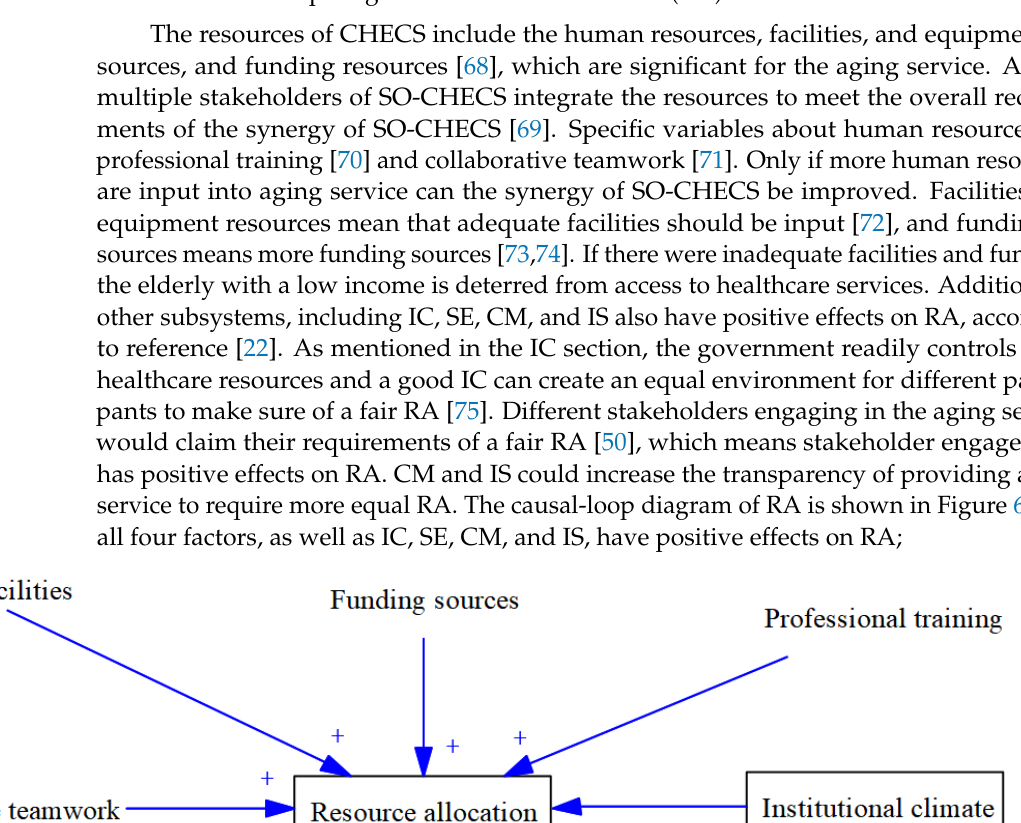
Figure 6. The causal-loop diagram of RA. •